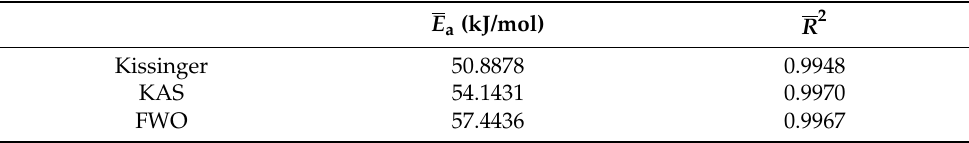
Table 5. E a and R 2 values obtained by Kissinger, KAS and FWO